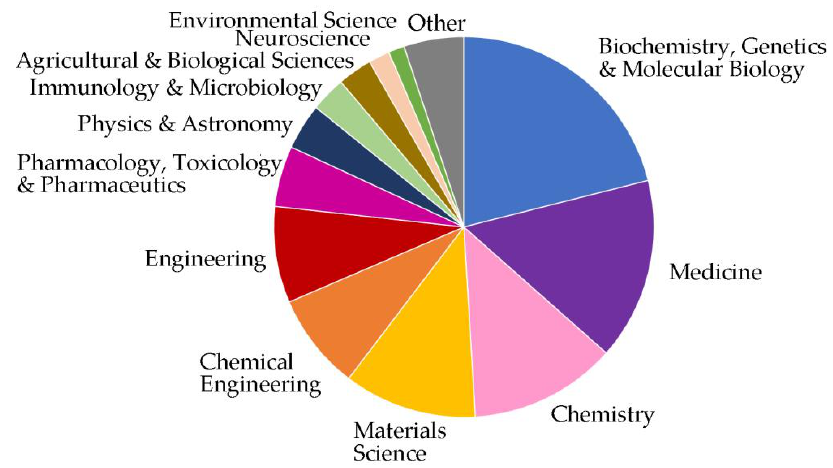
Figure 2. Subject areas of the publications shown in Figure 1.